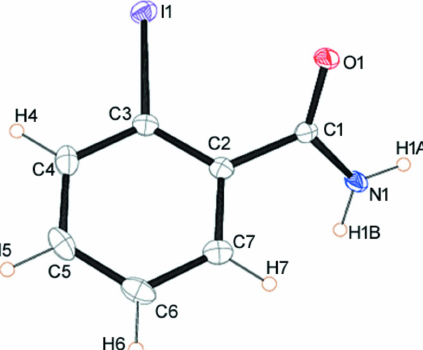
Figure 1 The molecular structure of (I) showing the atom numbering with ellipsoids drawn at the 50% probability level.